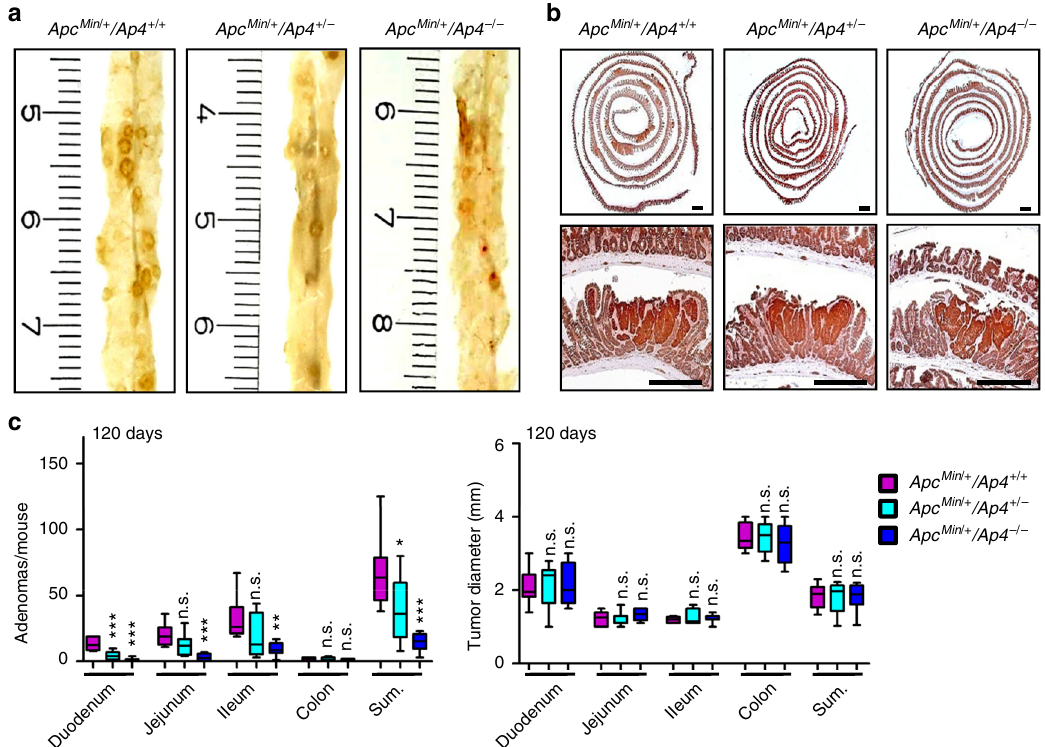
Fig. 2 Ap4 deletion decreases frequency but not size of adenomas in age-matched Apc Min/ + mice. a Macroscopic pathology of representative polyps in the small intestine (ileum) of 120 days old Apc Min/ + mice with the indicated genotype, scale in cm. b Representative sections through rolls of the small intestine were stained for β -catenin. Scale bar = 500 µ m (upper pictures) or 250 µ m (lower pictures). c Quanti fi cation of adenoma number/mouse (left panel) and tumor diameter (right panel) in the intestine of four male and four female 120 days old Apc Min/ + mice per genotype. The box extends from the 25th to 75th percentiles. The line in the middle of the box is plotted at the median. The whiskers represent the minimal and maximal values. c Results represent the mean ± SD. Results were subjected to an unpaired, two-tailed Student ’ s t -test with p -values * < 0.05, ** < 0.01, *** < 0.001, n.s.: not signi fi cant. See also Supplementary Fig.